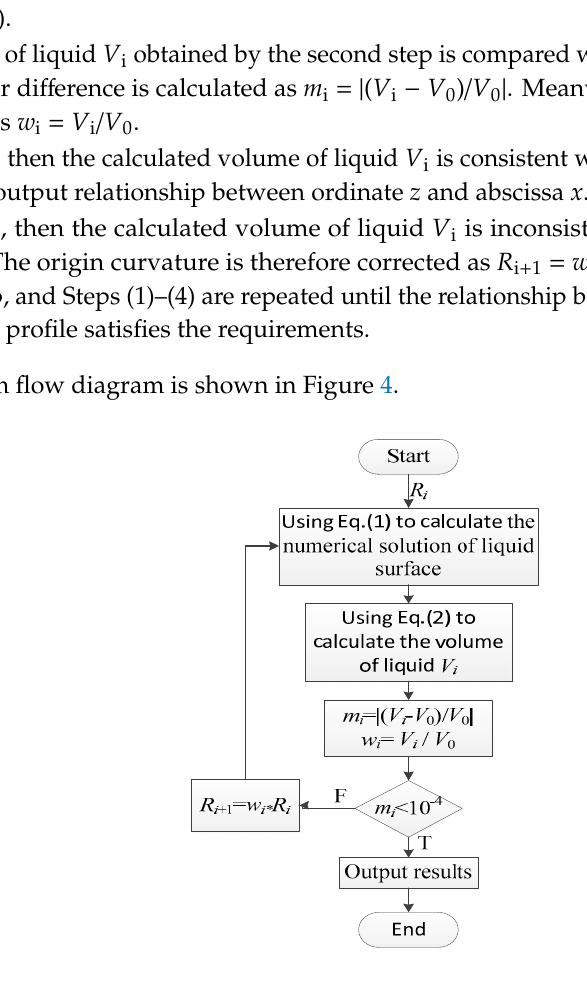
Figure 4. Program flow diagram.